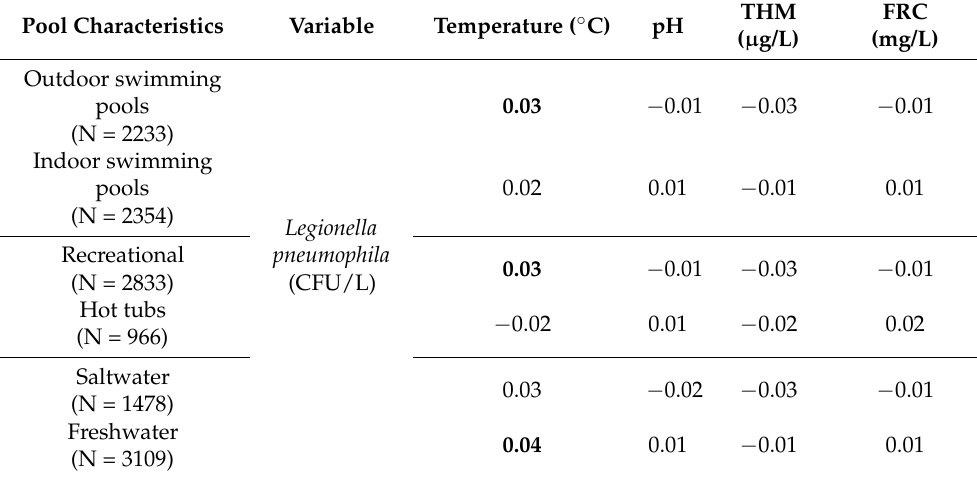
Table 1. Correlation coefficients between physicochemical parameters of analyzed swimming water pools (temperature ( ◦ C), pH, trihalomethanes (THM; µ g/L), free residual chlorine (FRC; mg/L), and Legionella pneumophila (CFU/L) and different pool characteristics (outdoor, indoor, recreational, hot tubs, saltwater, and freshwater), represented by non-parametric Kendall’s Tau correlation test. Statistically significant correlations ( p < 0.05) are presented with bold type numbers. Pool Characteristics Variable Temperature ( ◦